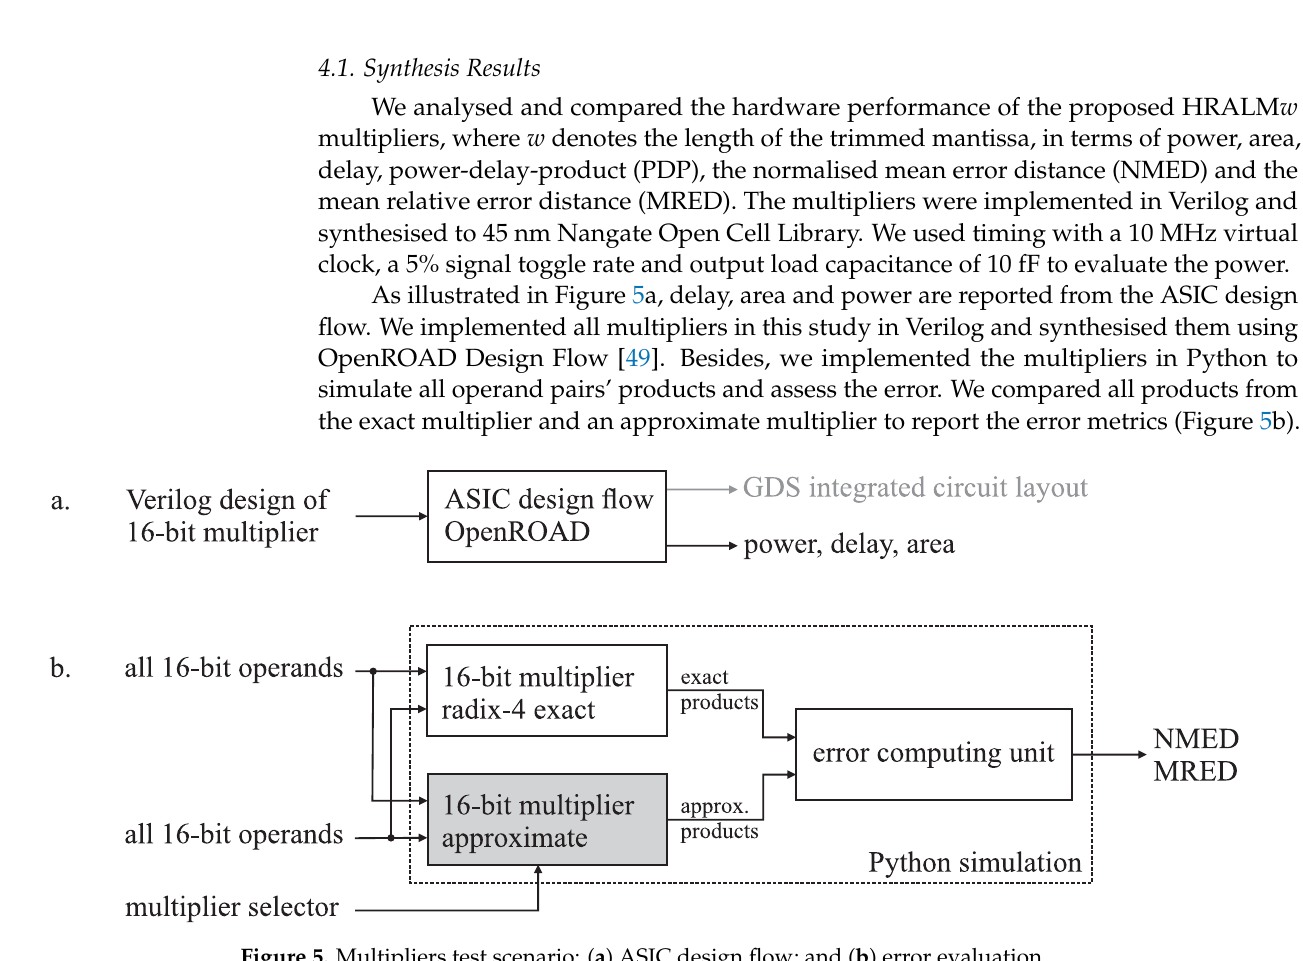
Figure 5. Multipliers test scenario: ( a ) ASIC design flow; and ( b ) error evaluation. Table 2 shows the synthesis results and error metrics for all multipliers. Table 2. The synthesis results, NMED (normalised mean error distance) and MRED (mean relative error distance) for 16-bit